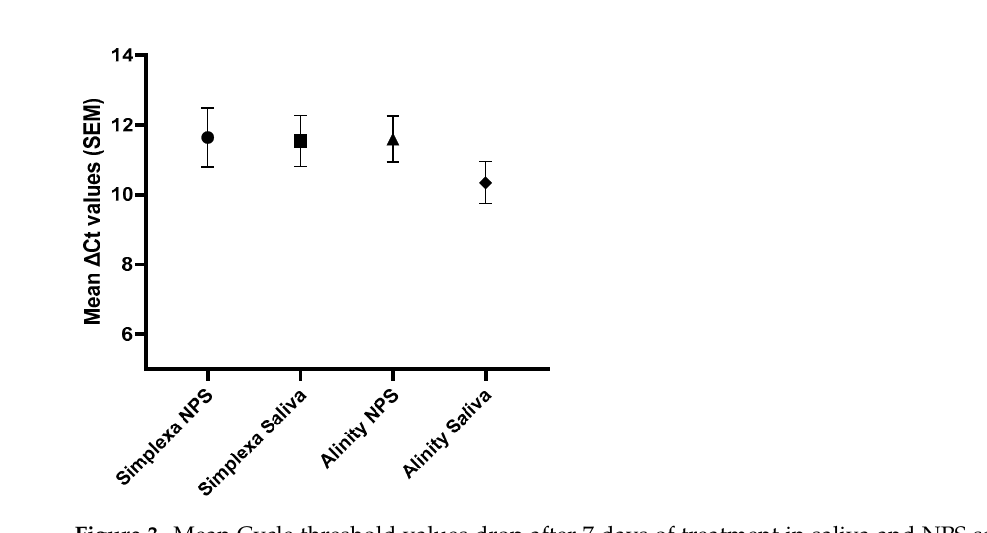
Figure 3. Mean Cycle threshold values drop after 7 days of treatment in saliva and NPS samples. Results are expressed as mean ∆ Ct (Ct T7–Ct T0), obtained using both Simplexa and Alinity